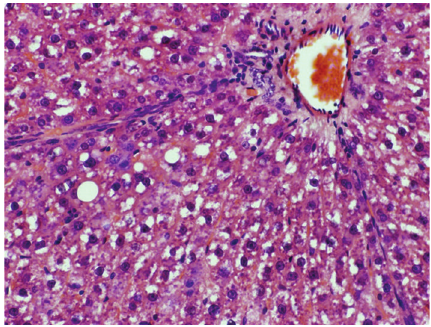
Figure 11: Macrovesicular steatosis, involving most regions of the hepatic lobule. The intracytoplasmic fat is seen as white vacuoles in a rat of the NC group.